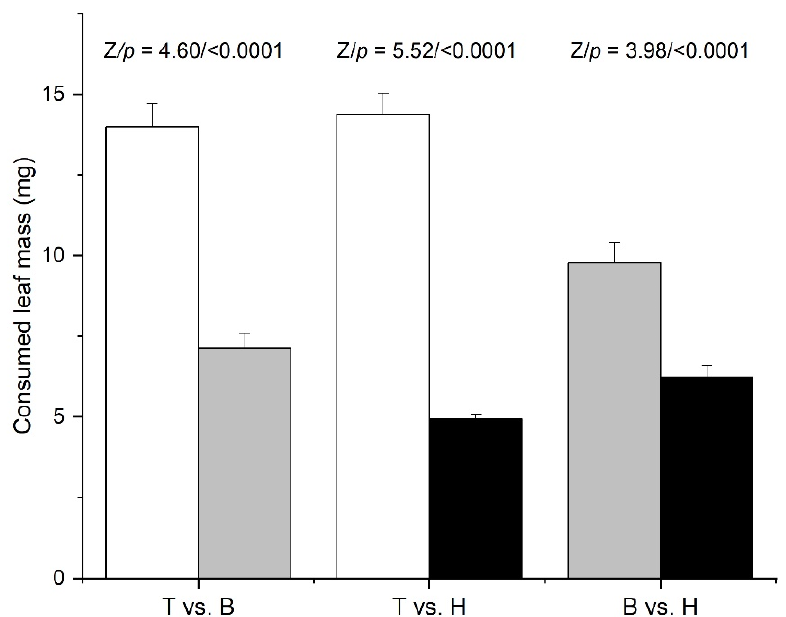
Figure 1. The preference in terms of consumed leaf mass (mean ± SE) by 2nd instar GM larvae in two choice assays of three leaf pairs: Turkey oak versus. beech (T vs. B); Turkey oak versus hornbeam (T vs. H), beach versus hornbeam (B vs. H). Consumption of Turkey oak, beech and hornbeam leaves are presented in hollow, grey and black bars, respectively. The comparison of the area consumed in each host plant pair was done using Wilcoxon matched pairs test (Z and p values are presented above the bars). Table 3. Performance indices (mean ± SE) for 4th instar GM larvae depending on host plant. After one-way ANOVA (see Table 4) or ANCOVA (see Table 5) data were compared by Tukey HSD post hoc test and significantly different values were marked by different letters within a row ( p <